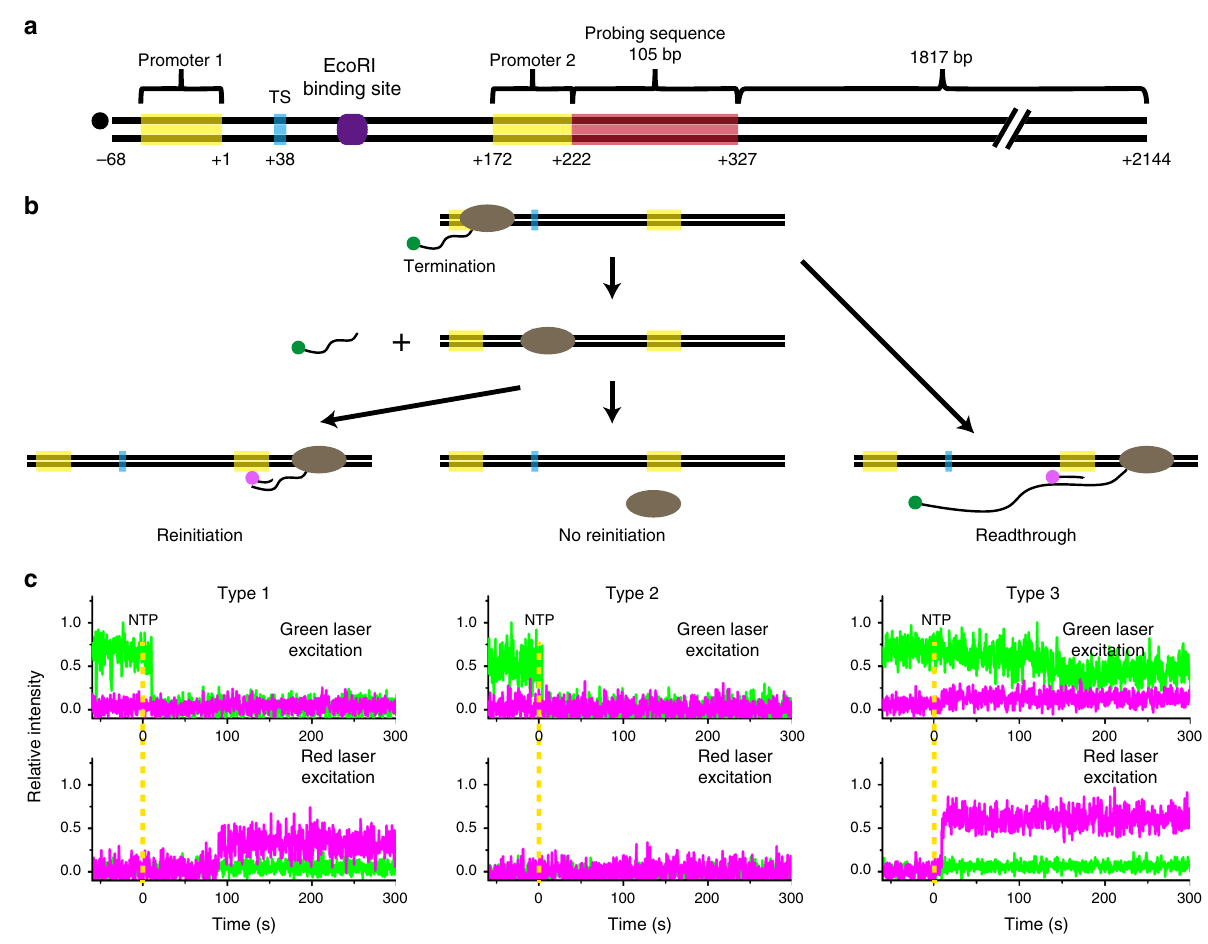
Fig. 5 Detection of transcriptional reinitiation. a A DNA template contains two transcription units with a roadblock (purple hexagon) between them. Transcripts from the downstream unit have a probing target (brown box). b Three possible courses are reinitiation on the downstream unit after TS termination, no reinitiation after TS termination, and readthrough at TS with continued downstream transcription. c Three types of fl uorescence time traces were observed; Cy3 vanishing with Cy5 probing (type 1), Cy3 vanishing without Cy5 probing (type 2), and Cy3 nonvanishing with Cy5 probing (type 3).